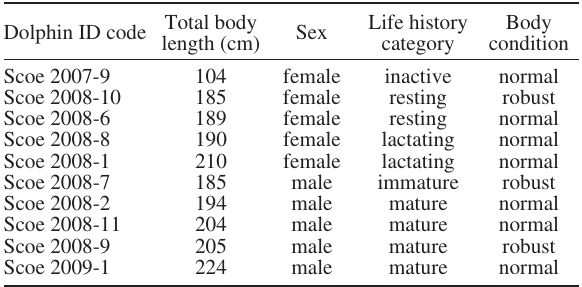
Table 1. – Striped dolphin ( Stenella coeruleoalba ) specimens used in this